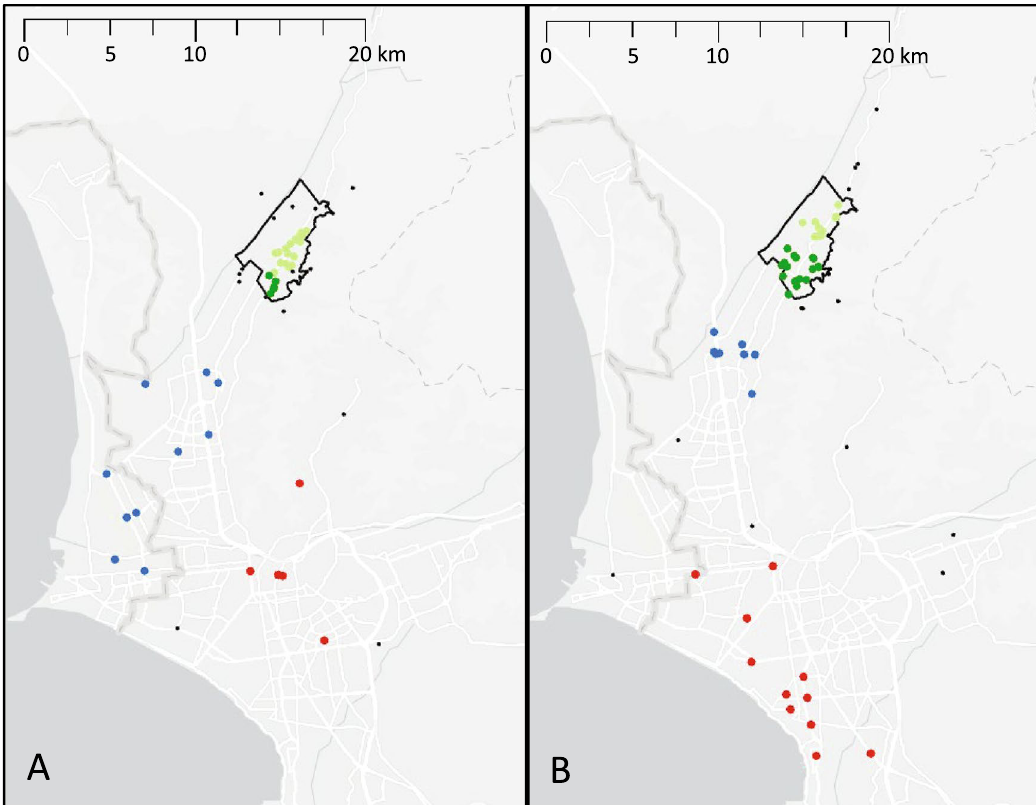
Figure 2. Density-based clustering of locations where participants reported having worked during the past 6 months. Each dot represents a location reported by a study participant, with colors representing clusters and black dots representing non-clustered locations. The black outline indicates the study area. ( A ) For TB patients, locations clustered around the main avenue within the study area (green dots) with another large but disperse cluster closer to the port of Callao (blue dots). ( B ) For control group participants, clusters were identified within the study area (green dots), in a neighboring district (blue dots), and in the more affluent Central Lima region (red dots). Map was created by MBB using ArcGIS Pro Version 2.8.0 (Environmental Systems Research Institute, Redlands, California,